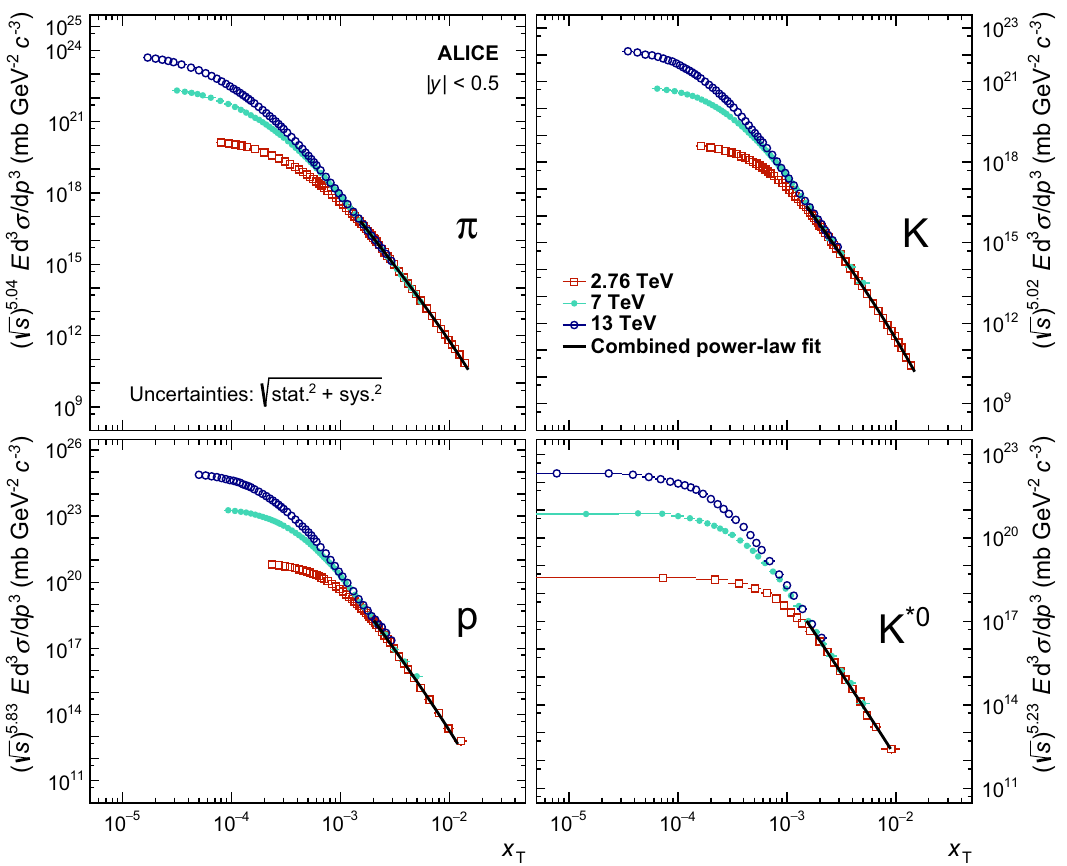
Fig. 9 Scaled invariant yields of π ± , K ± , p ( p ) , and K ∗ 0 as a function of x T = 2 p T / √ s = 2 . 76 TeV [7,63], gies of s = 13 TeV. The solid line represents a combined